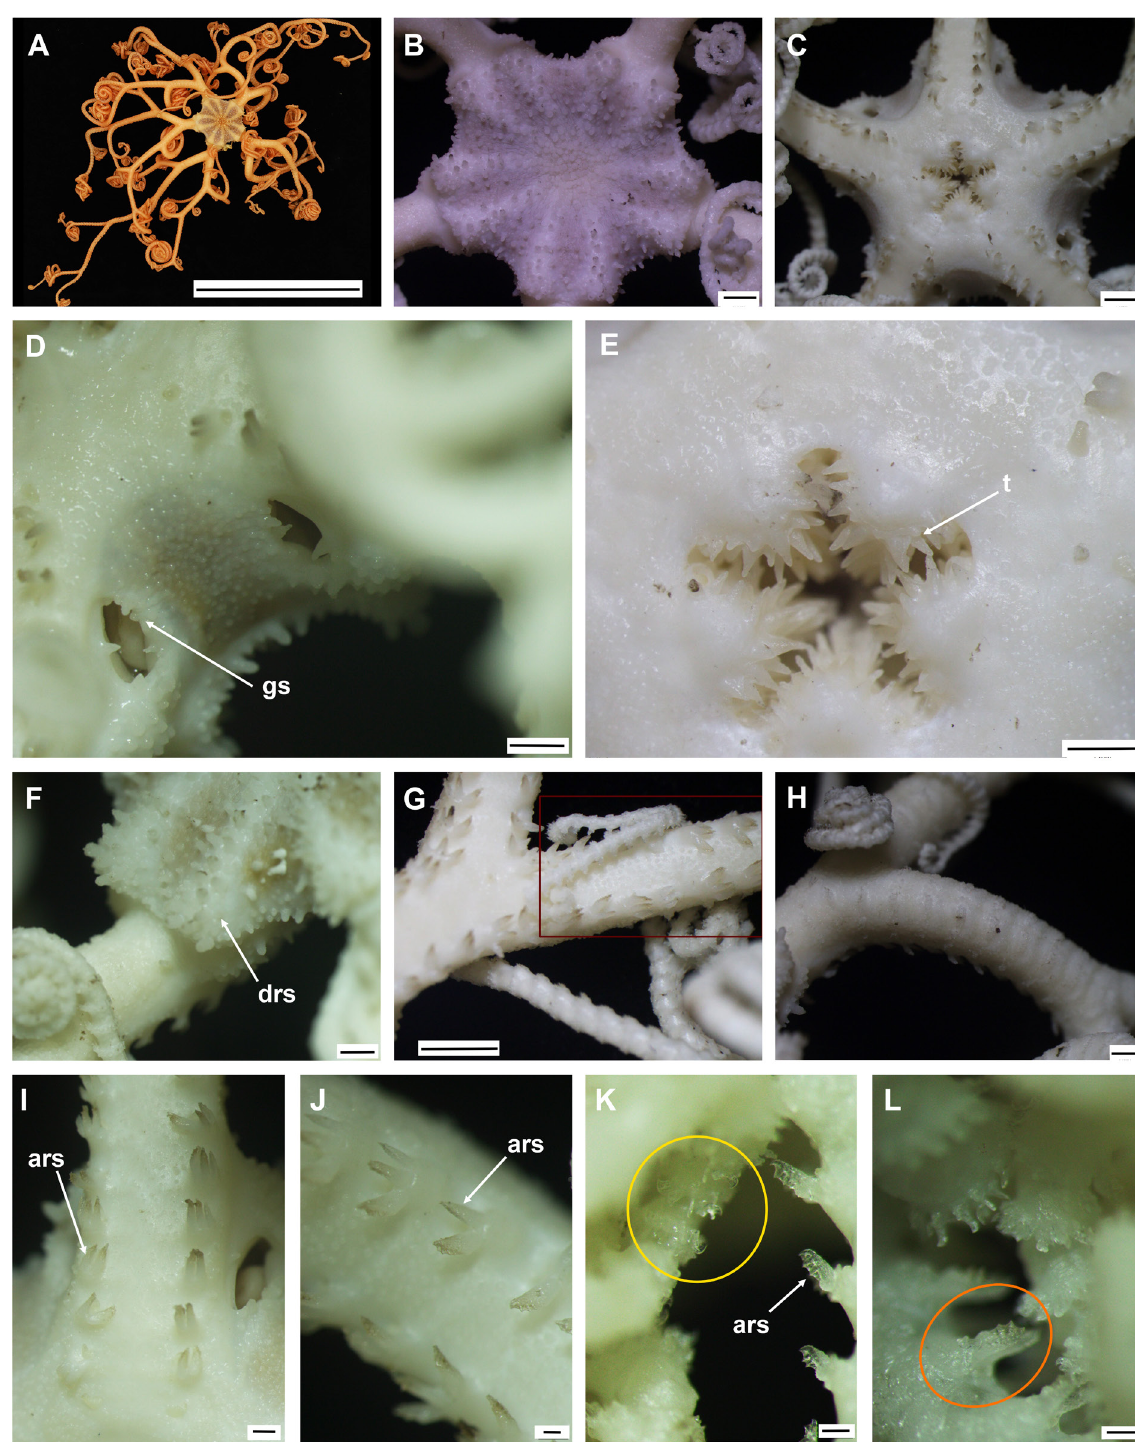
Fig. 9. Gorgonocephalus chilensis novaezelandiae Mortensen, 1924 (IDSSE EEB-SW0005). A . Live specimen. B . Dorsal disc. C . Ventral disc. D . Lateral disc. E . Oral frame. F . Dorsal view of disc periphery. G . Ventral view of first branch of an arm. H . Dorsal view of first branch of an arm. I . Ventral view of arm base. J–L . Variations of arm spines and pedicellariae along the arm. Abbreviations: ars = arm spine; drs = distal end of radial shield; gs = genital slit; t = teeth. Scale bars: A = 5 cm; B–C, G = 2 mm; D–F, H = 1 mm; I = 500 µm; J–L = 200